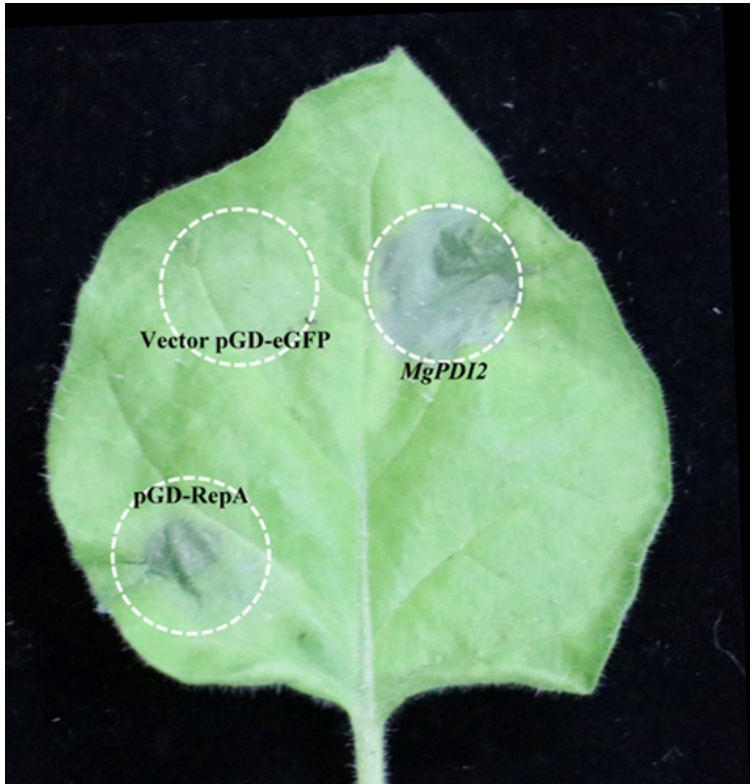
Figure 7. Transient expression of MgPDI2 induces cell death in N. benthamiana . Infiltration of Agrobacterium tumefaciens strain EHA 105 carrying a MgPDI2 expression construct into leaves of 6-week-old N. benthamiana plants. Empty pGD-eGFP vector was used as a negative control, while pGD-RepA was used as a positive control.